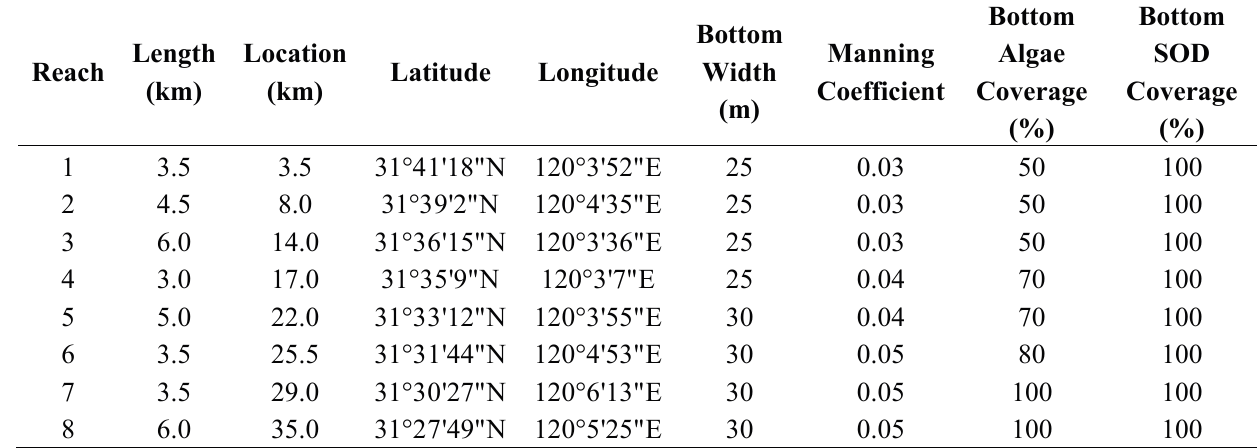
Table 2. The locations and hydraulic characteristics of eight reaches.